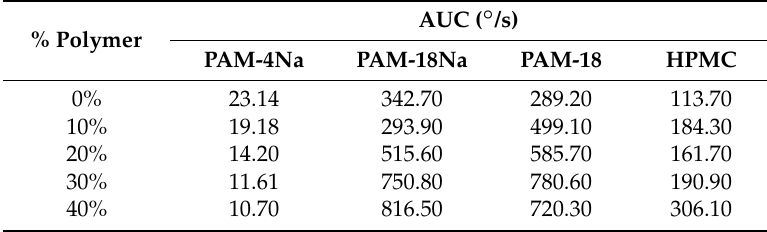
Figure 5. Profiles of θ c vs. t for ampicillin trihydrate tablets alone and with polymeric materials at different rates. Time values correspond to the normalized values of drop age. Table 5. AUC values of θ c vs. t profiles for ampicillin trihydrate tablets at different ratios of polymer.